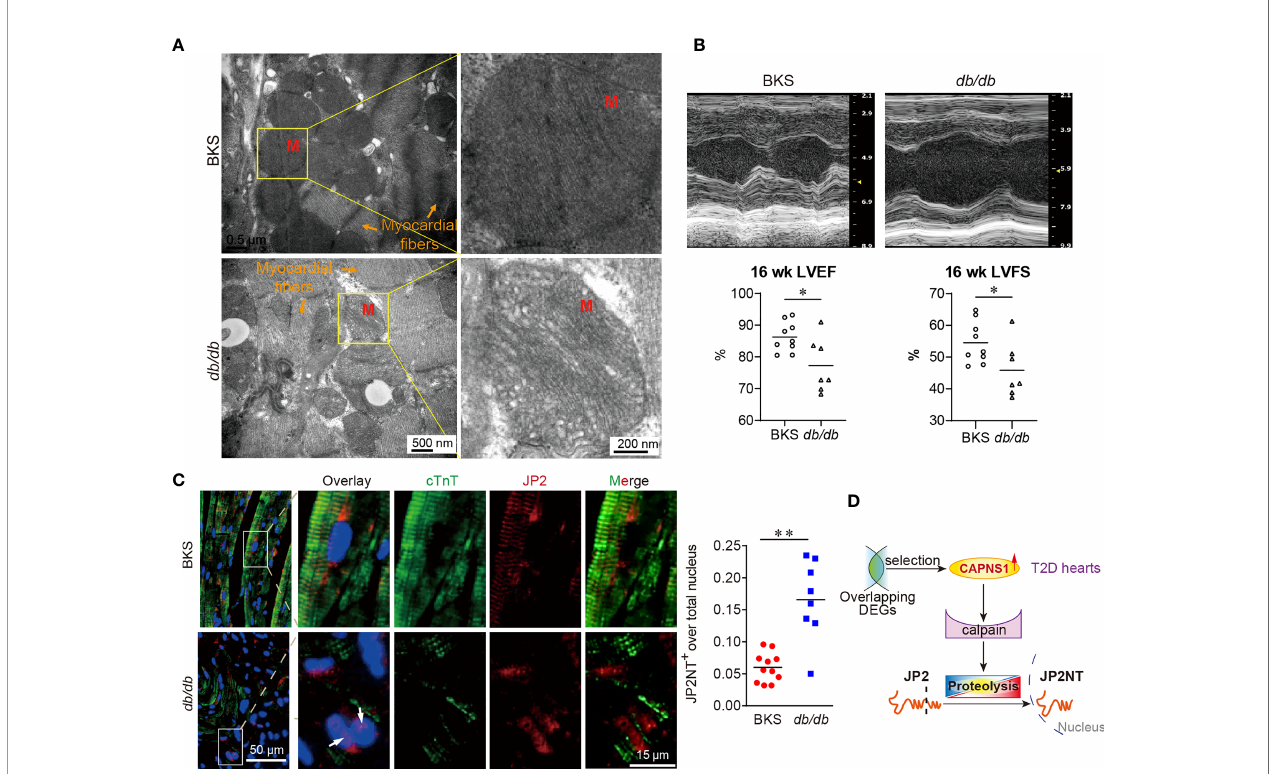
FIGURE 5 | Mitochondrial cristae disruption and hydrolyzed JP2 nuclear translocation in myocardium of db/db mice. (A) Electron micrographs showed the decreased areas of cristae organization and density of mitochondria (M) in db/db mice compared with controls. Scale bar: 500 nm and 200 nm. (B) Representative images of echocardiography. Both left ventricular ejection fraction (LVEF) and left ventricular fraction shortening (LVFS) decreased. * P < 0.05, n =9 (BKS mice), n =7 ( db/db mice). * P < 0.05, ** P < 0.01. (C) The abundance and distribution of JP2 (red) changed in cardiomyocytes (green, cTnT) of T2D heart. The colocalization of JP2NT (red) with nuclei (blue, DAPI) appear in cardiomyocytes of T2D heart (arrow: nuclear JP2NT). (D) In the case of cardiac mitochondrial ultrastructure lesions, and cardiac dysfunction in T2D hearts, the hydrolyzed product JP2NT import into the nucleus of myocardium. Scale bar: 50 m m and 15 m m (left panel). Ratio of JP2NT existed in nuclei were showed in dot chart (right panel) (n=8~11, 4 random fi elds for each